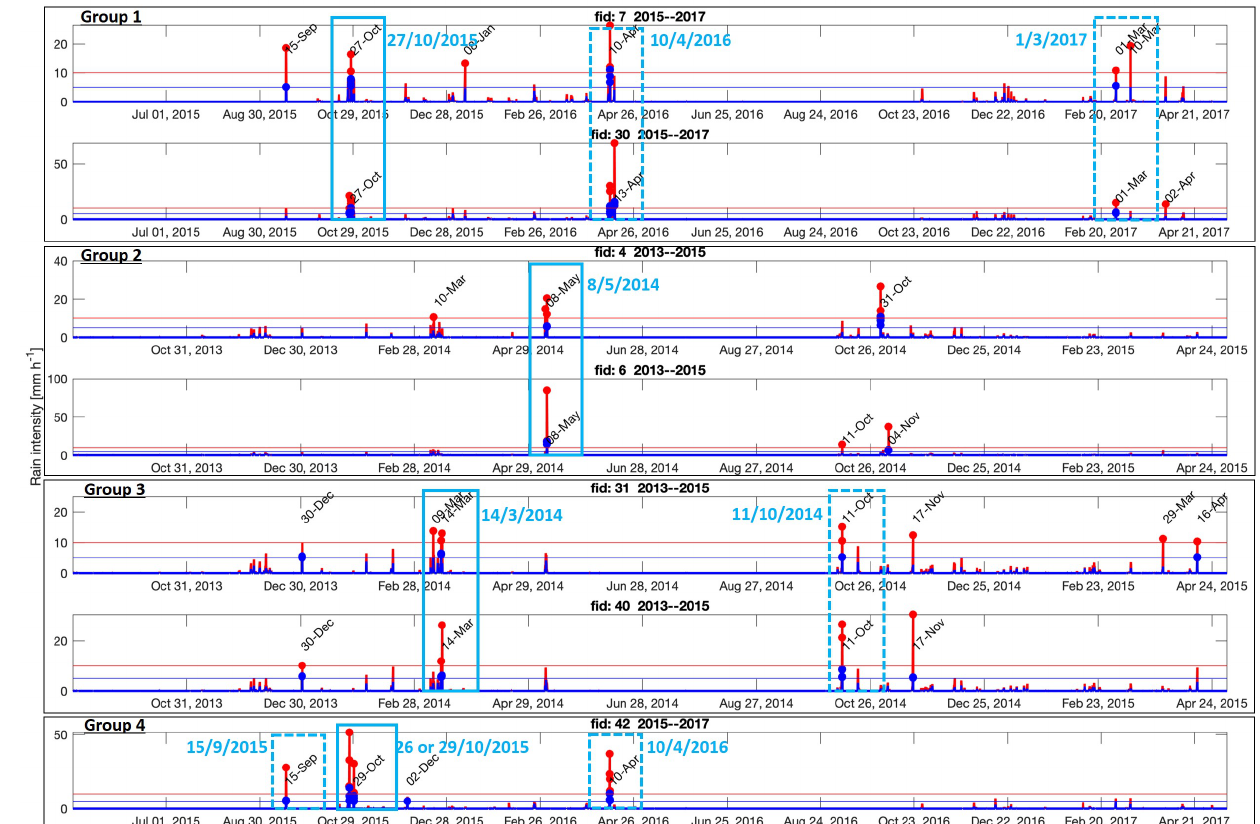
Figure 6. Time series of rainfall events over the four groups of DFs. Seven sub-plots of the rainfall intensity versus time (for 2-year intervals) for seven DFs related to four different groups. In each sub-plot two graphs are shown: the rain intensity in 5min intervals (in red) and the smoothed intensity observed over 30min moving windows (in blue). Horizontal lines mark the two thresholds of 10mmh − 1 (red) and 5mmh − 1 (blue). Any storm during which the 5min intensity exceeds the 10mmh − 1 threshold or the 30min intensity overcomes the 5mmh − 1 threshold is marked by a red or blue dot, respectively. Storms exceeding both thresholds for all the DFs of a group are considered potential triggering storms (marked by dashed light blue box); among them, the chosen storms are marked by solid light blue